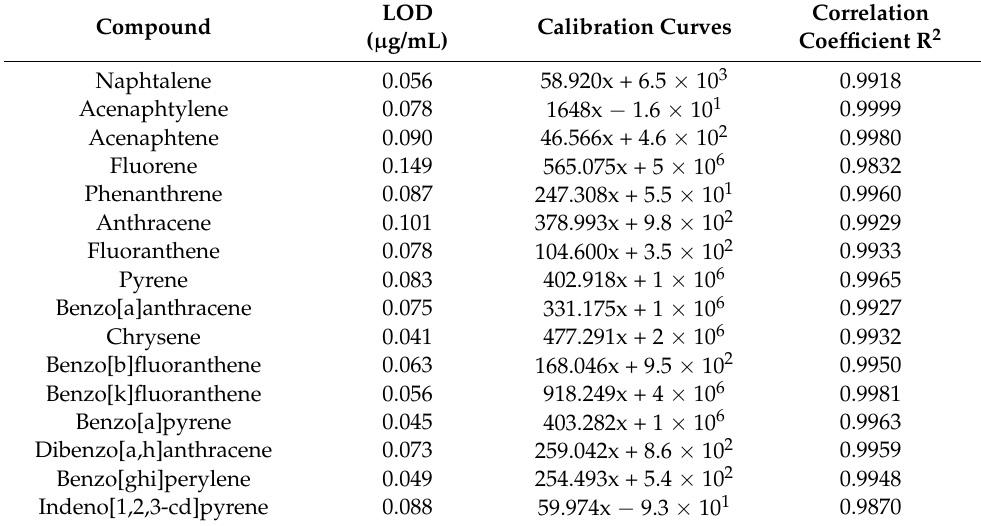
Table 3. Detection limits, linear range, and calibration of the quantification of PAHs.